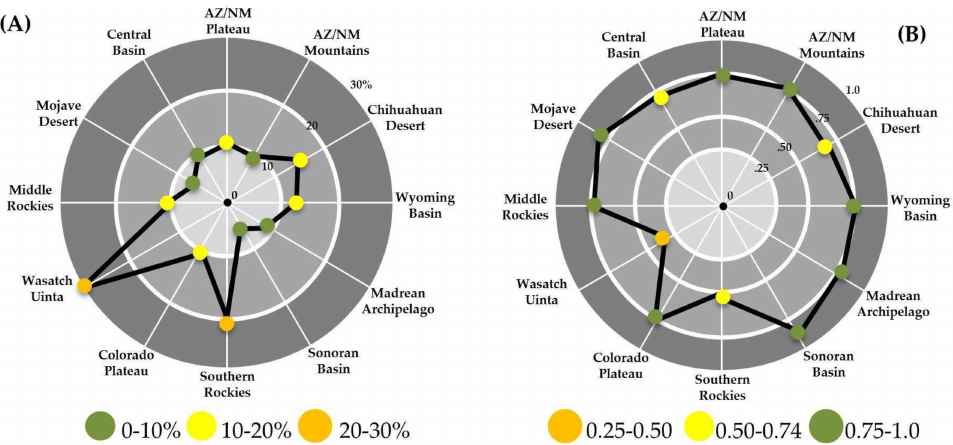
Figure 5. Radar charts displaying cross-validated error rates ( A ) (0–100%) and Kappa ( B ) (0–1) for each of the final random forests classification models. Model performance is best when error rates (A) are closer to the center and when kappa values (B) are closer to the perimeter of the chart.